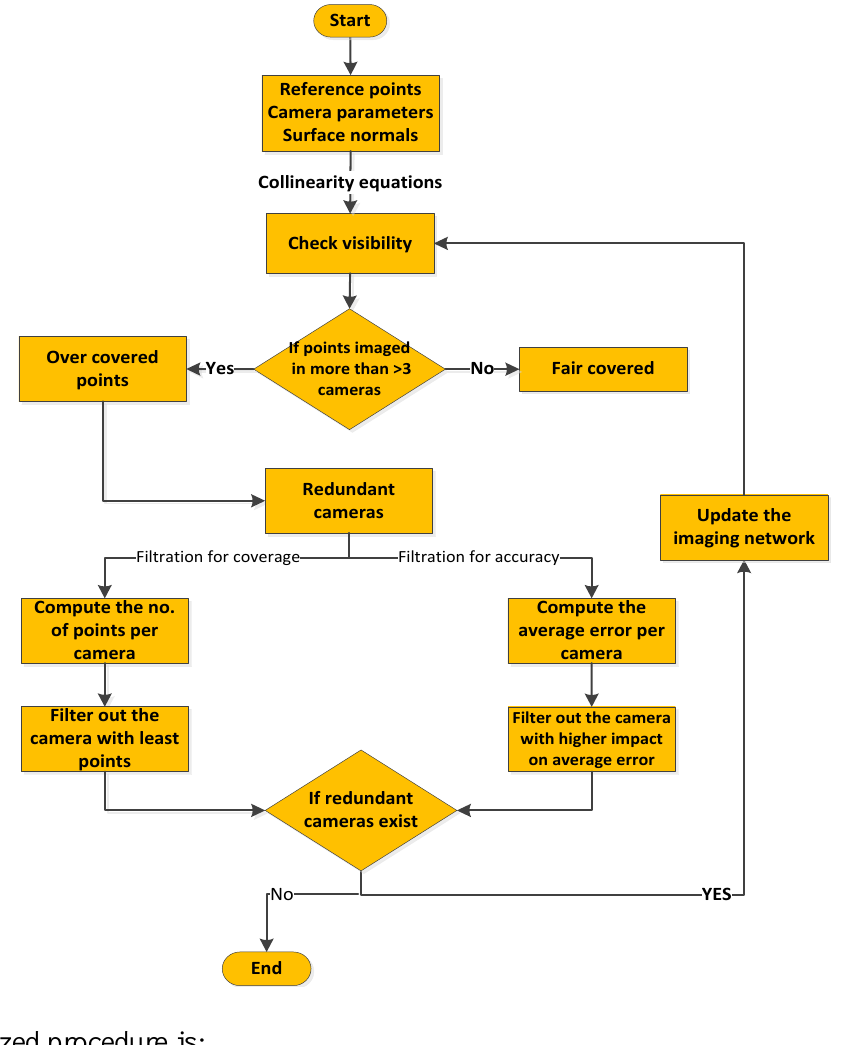
Figure 3. A methodology flowchart of filtering for coverage and accuracy